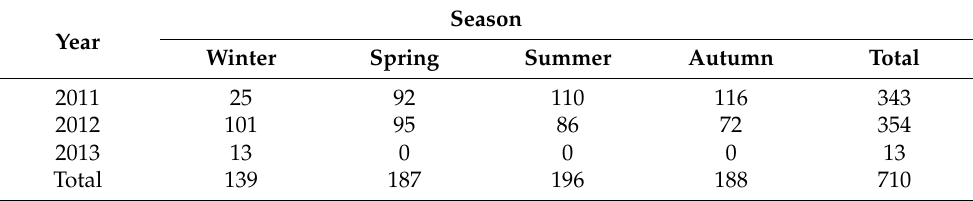
Table 2. Distribution of Microtus lusitanicus analysed by year and season of capture.